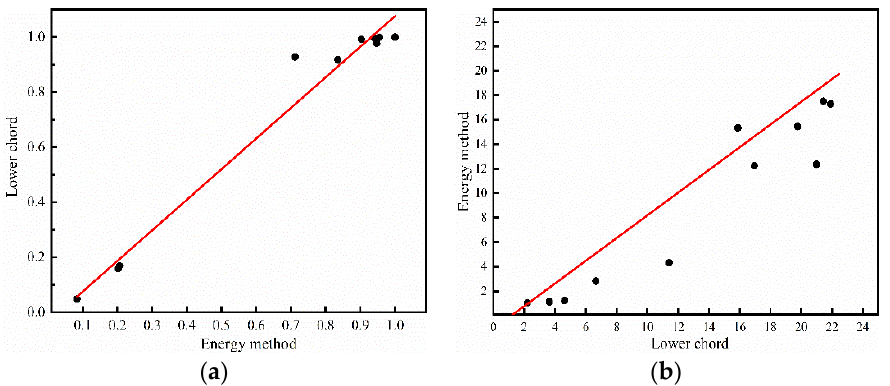
Figure 16. Relationship between energy method and sensitivity analysis method: ( a ) Test truss, ( b ) steel roof truss.